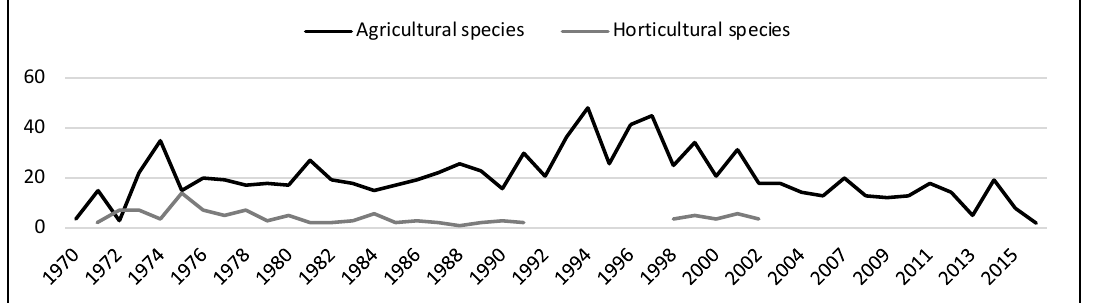
Fig. 2. Registrations in the Swedish National List of Plant Varieties